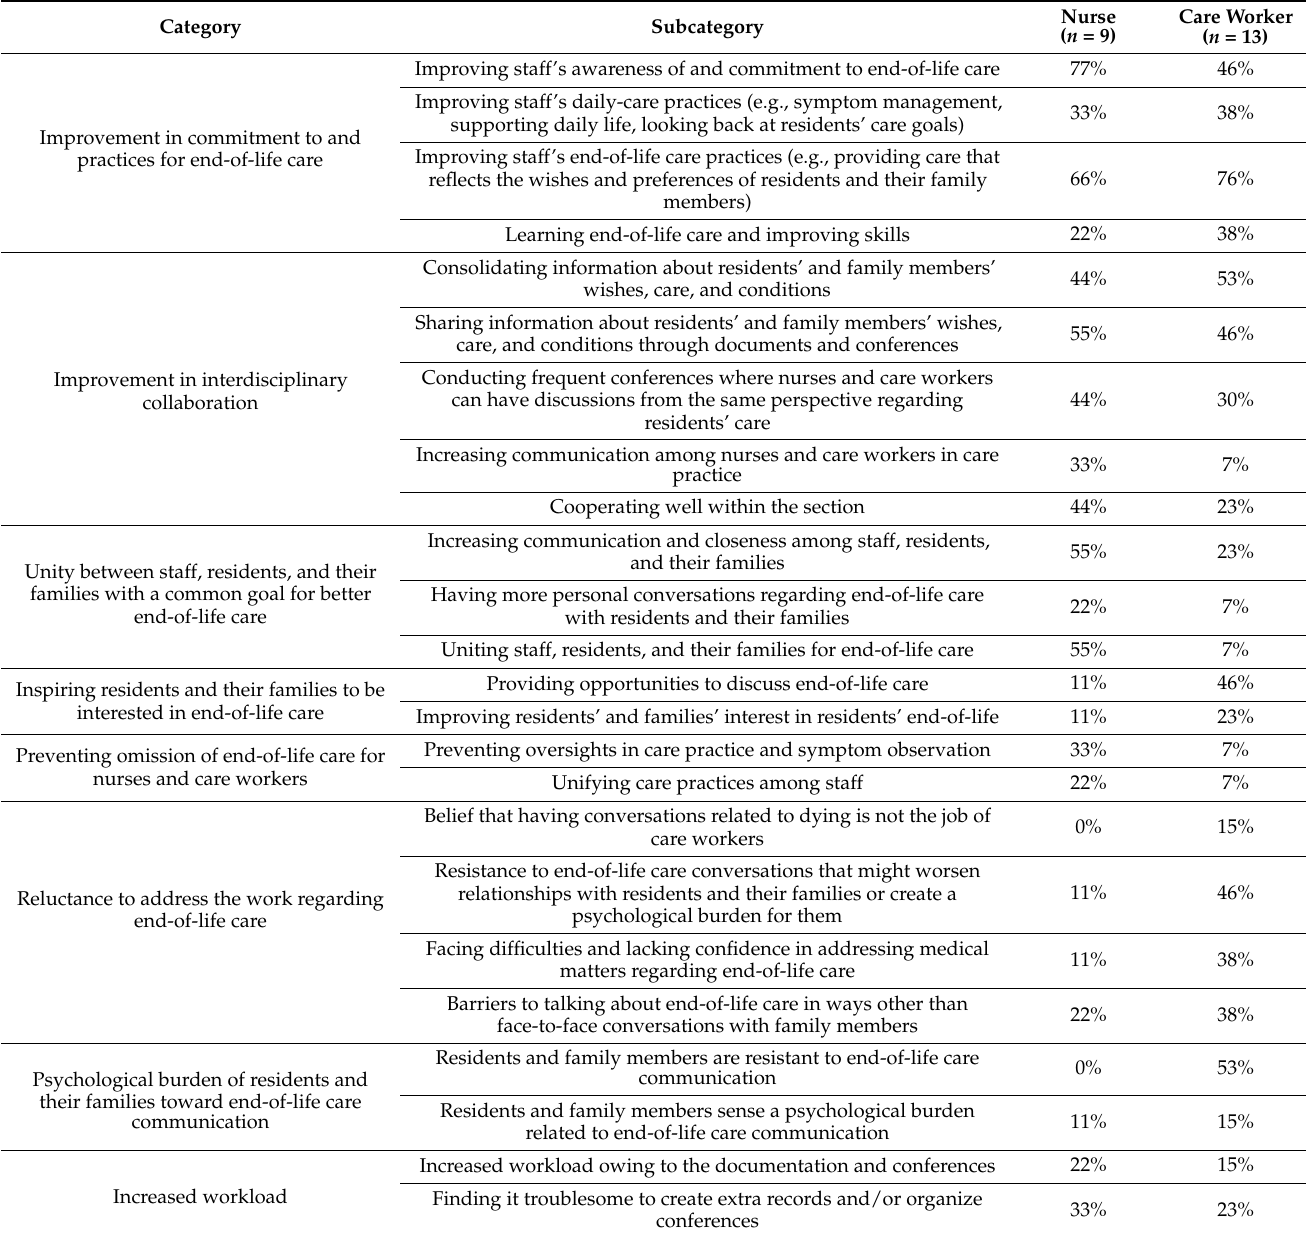
Table 5. Nurses’ and care workers’ perceptions of the EOL Care Tool ( n =